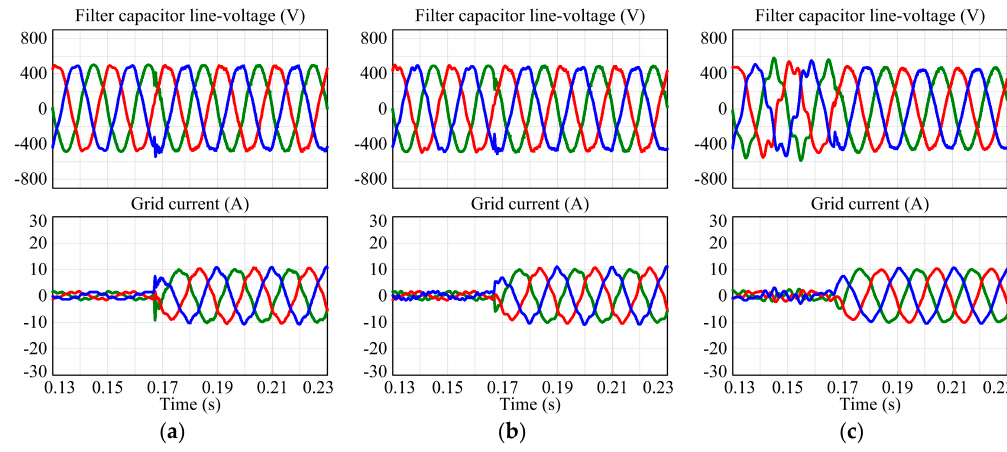
Figure 24. Simulation results of grid-connected converter starting in rectifier mode with DFPS-CVFF under distorted grid; ( a ) L ’ g = 0; ( b ) SCR = 10; ( c ) SCR = 2.